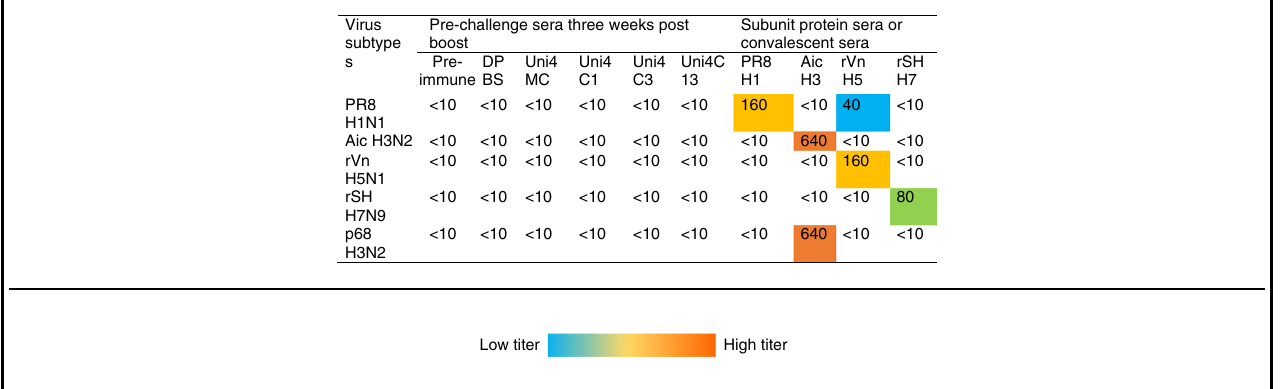
A panel of viruses including PR8, Aic, rVn, rSH, and A/Hong Kong/1/1968 (H3N2, p68) were tested for HAI. Immune sera against HA proteins PR8 H1, Aic H3, and rSH H7 and convalescent sera from rVn virus infection were used as positive controls. The lowest serum dilution able to inhibit virus hemagglutination is shown ( n = 10)